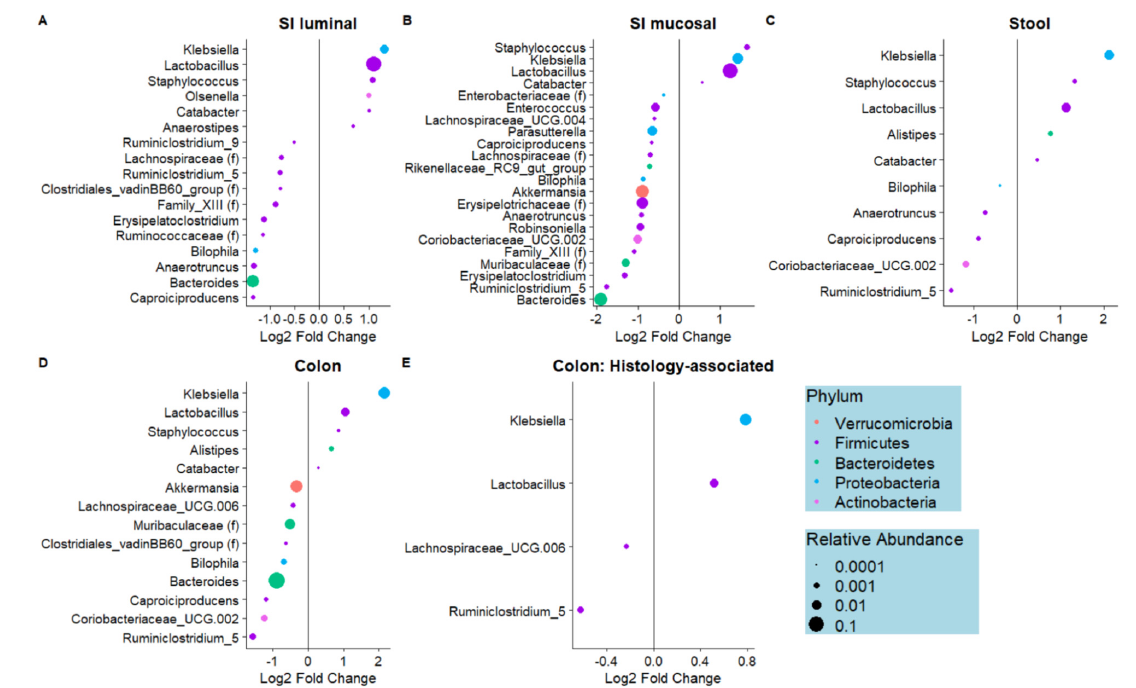
Figure 3. Significant dietary biotin-deficiency-associated and histology-associated genera. Per-genus association testing was performed utilizing linear models fitted to log-transformed, TSS normalized count data with Sex and Diet as covariates ( A–D ), or Sex and Histology Score as covariates ( E ). Modeling was performed separately for samples obtained from each region of the GI tract; small intestinal (SI) luminal ( A ), SI mucosal-adherent ( B ), stool ( C ), and colon ( D , E ). Genera which were significantly differentially abundant ( q < 0.05) in the biotin-deficient (BD) group compared to control diet (CD) are represented as dots colored by phylum and sized according to relative abundance, with the legend for all plots shown in ( E ). Relative to CD, genera with positive log2foldchange are enriched in BD, whereas genera with a negative log2foldchange are depleted in BD.